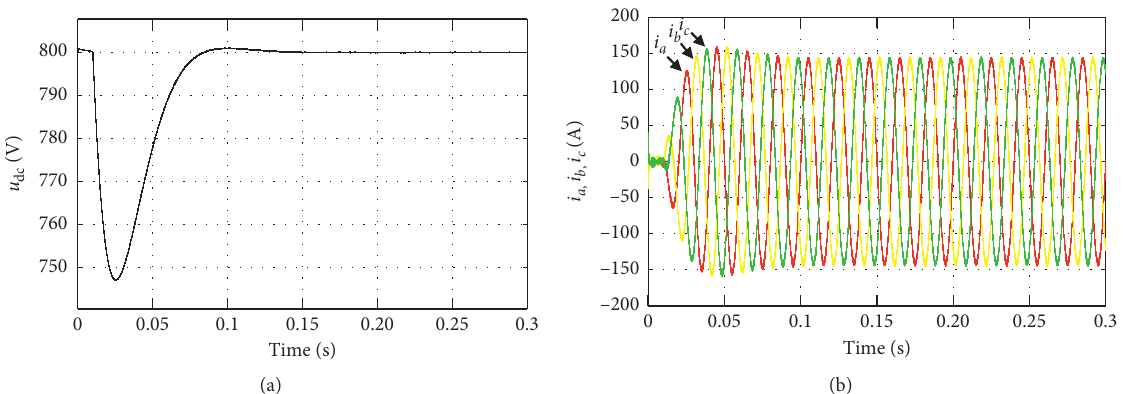
Figure 13: Step response of converter. (a) The step response of AC/DC converter DC bus voltage. (b) The step response of AC/DC converter grid-connected